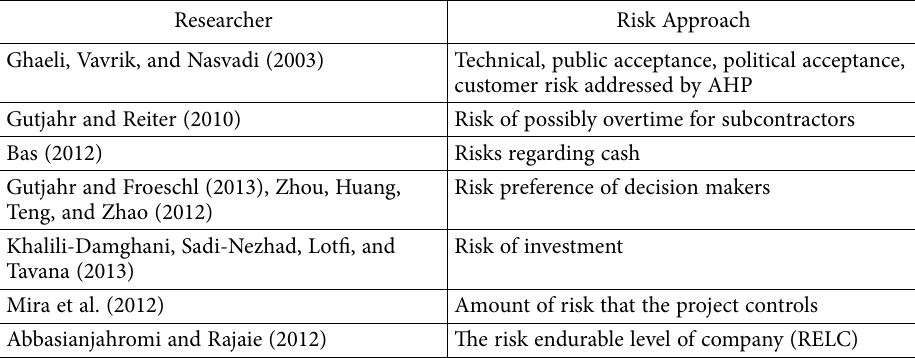
Table 3. Various aspects of risk addressed in PPS literature